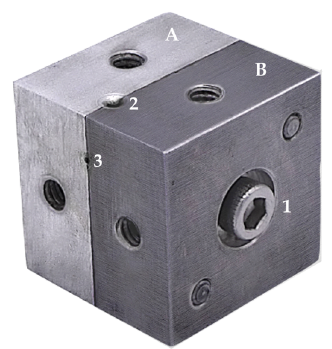
Figure 2. Two adjustable metal blocks ( A , B ) were screwed (1) to make a cyclic fatigue testing device. The tested instrument was inserted into the simulated canal via “orifice” (2) up to the terminal point (3) and subjected to rotation [19].